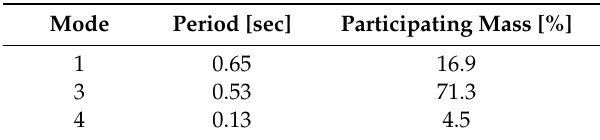
Table 3. Modal analysis of the bridge: relevant modes in the transversal direction (mode 1, mode 3 and mode 4) having a participating mass ratio >